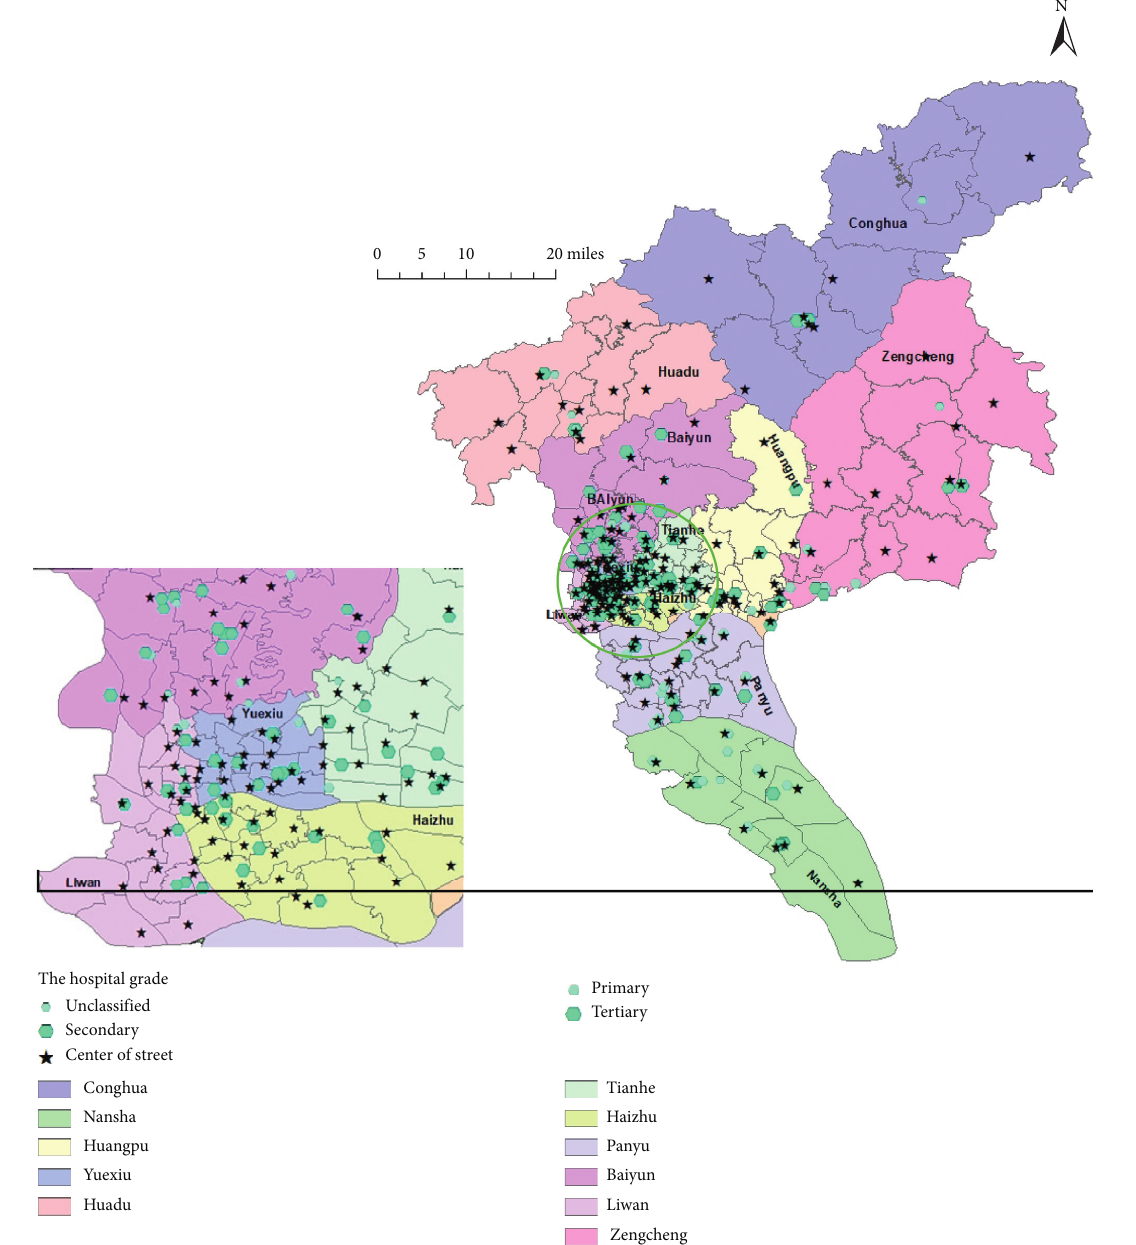
Figure 1: The spatial distribution of hospitals and